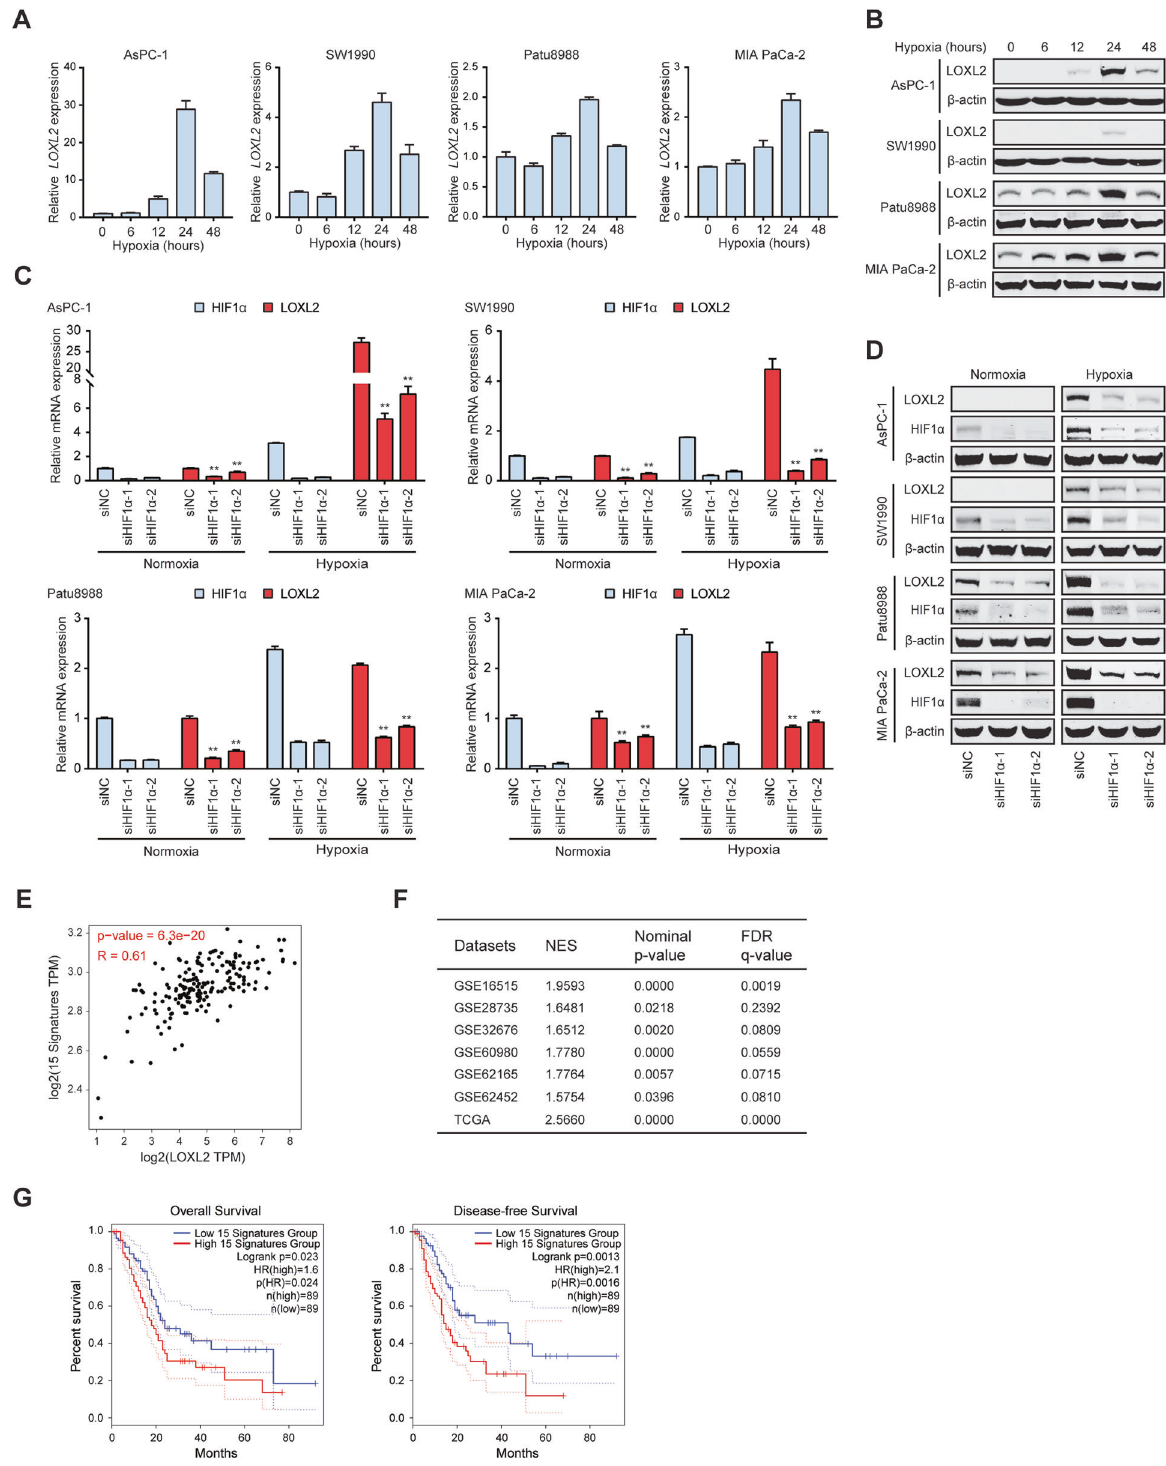
Fig. 2 LOXL2 is induced by hypoxia in PDAC. A LOXL2 mRNA expression in PDAC cells used for LOXL2 overexpression and knockdown exposed to hypoxia for 0 – 48 h examined by qRT-PCR. B LOXL2 protein expression in PDAC cells used for LOXL2 overexpression or knockdown exposed to hypoxia for 0 – 48 h examined by western blotting. C , D The expression of LOXL2 and HIF1 α at mRNA ( C ) and protein ( D ) levels in the indicated cells transiently transfected with siRNAs targeting HIF1 α exposed to normoxia or hypoxia for 24 h. E Correlation between LOXL2 expression and the 15-gene hypoxia signature in the PDAC samples of TCGA cohort. F Overall survival and disease-free survival analyses of PDAC patients with different hypoxia status in PDAC samples of TCGA cohort. G Positive correlation between LOXL2 expression and gene set HALLMARK_HYPOXIA in PDAC samples analyzed by GSEA based on the data from GEO and TCGA databases. * p < 0.05, ** p < 0.01.